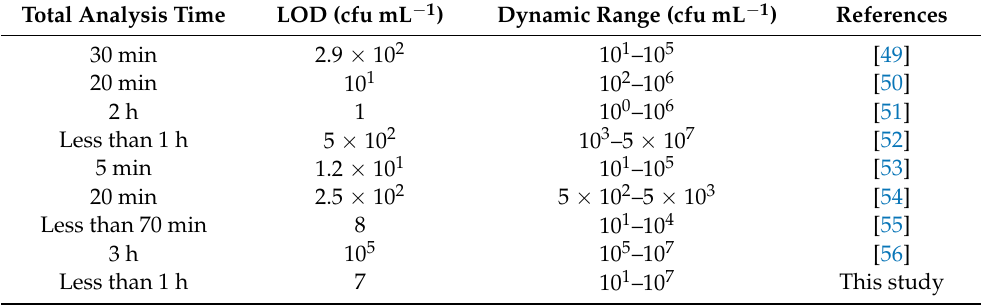
Table 2. Comparison of this proposed biosensor with other similar studies in the literature. Total Analysis